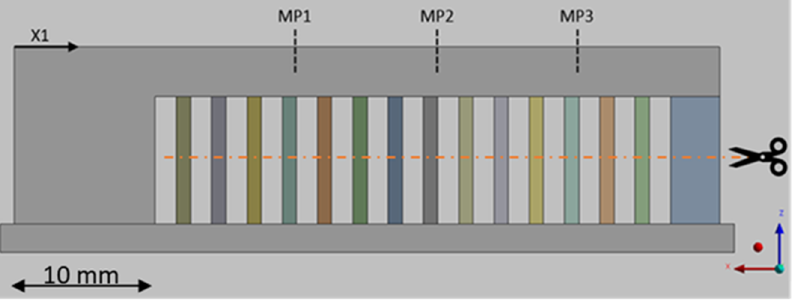
Figure 4. Side view of the distortion bridge with drawn-in measuring ranges for the residual stress.